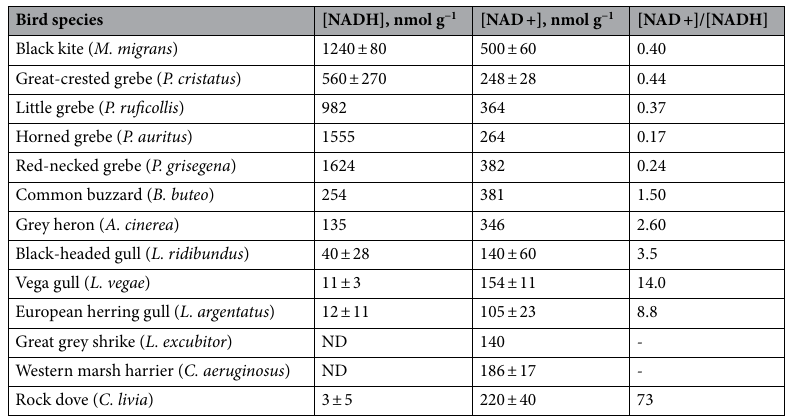
Table 2. Concentrations of NADH and NAD + in the bird lenses and the ratio of mean values [NAD +]/ [NADH]. ND not detected.